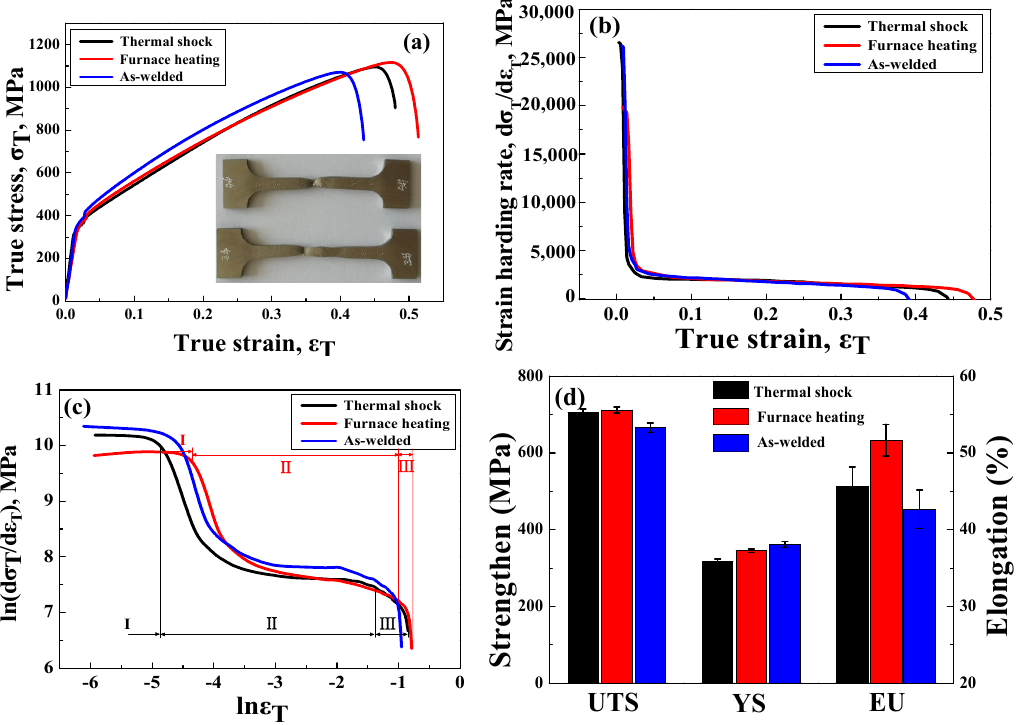
Figure 12. Changes in the mechanical properties of the TS and FH samples (for 6 h durations) and the as-welded samples, respectively. ( a ) True stress–strain curves. ( b ) Strain hardening rate–true strain curves. ( c ) The C–J analysis (ln (d σ T /d ε T ) vs. ln ε T ). ( d ) Distribution histograms of the mechanical properties. Table 4. The values of the true strains of each stage of the samples based on the C–J analysis. Sample